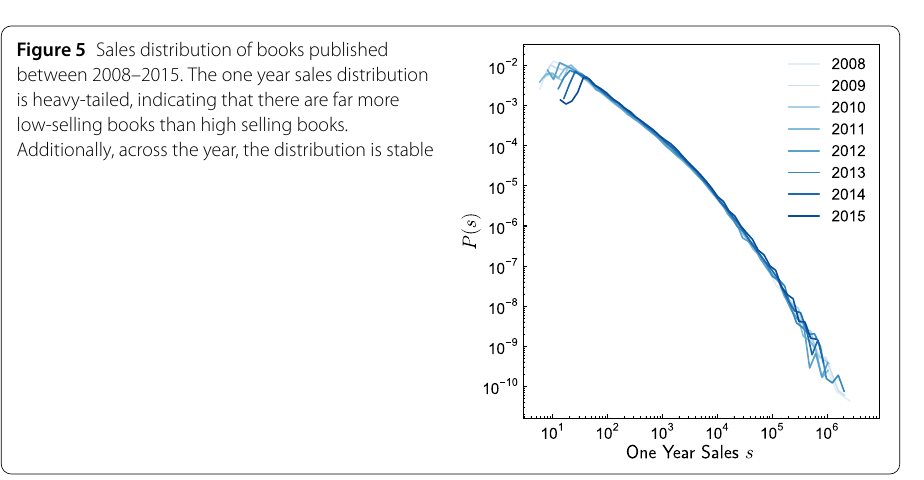
Figure 5 Sales distribution of books published between 2008–2015. The one year sales distribution is heavy-tailed, indicating that there are far more low-selling books than high selling